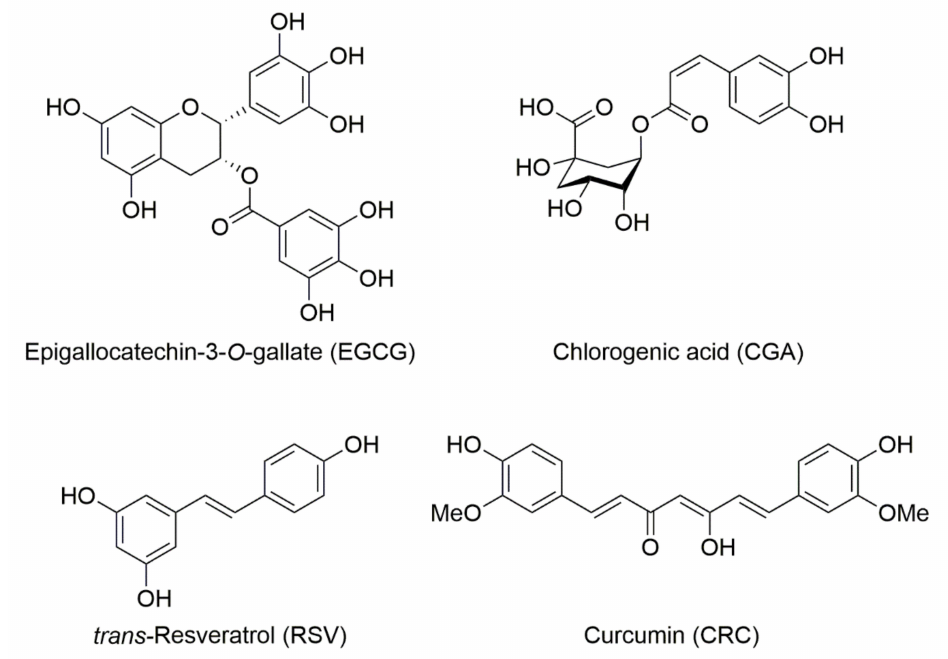
Figure 1. Chemical structures of epigallocatechin gallate (EGCG), chlorogenic acid (CGA), trans - resveratrol (RSV), and curcumin